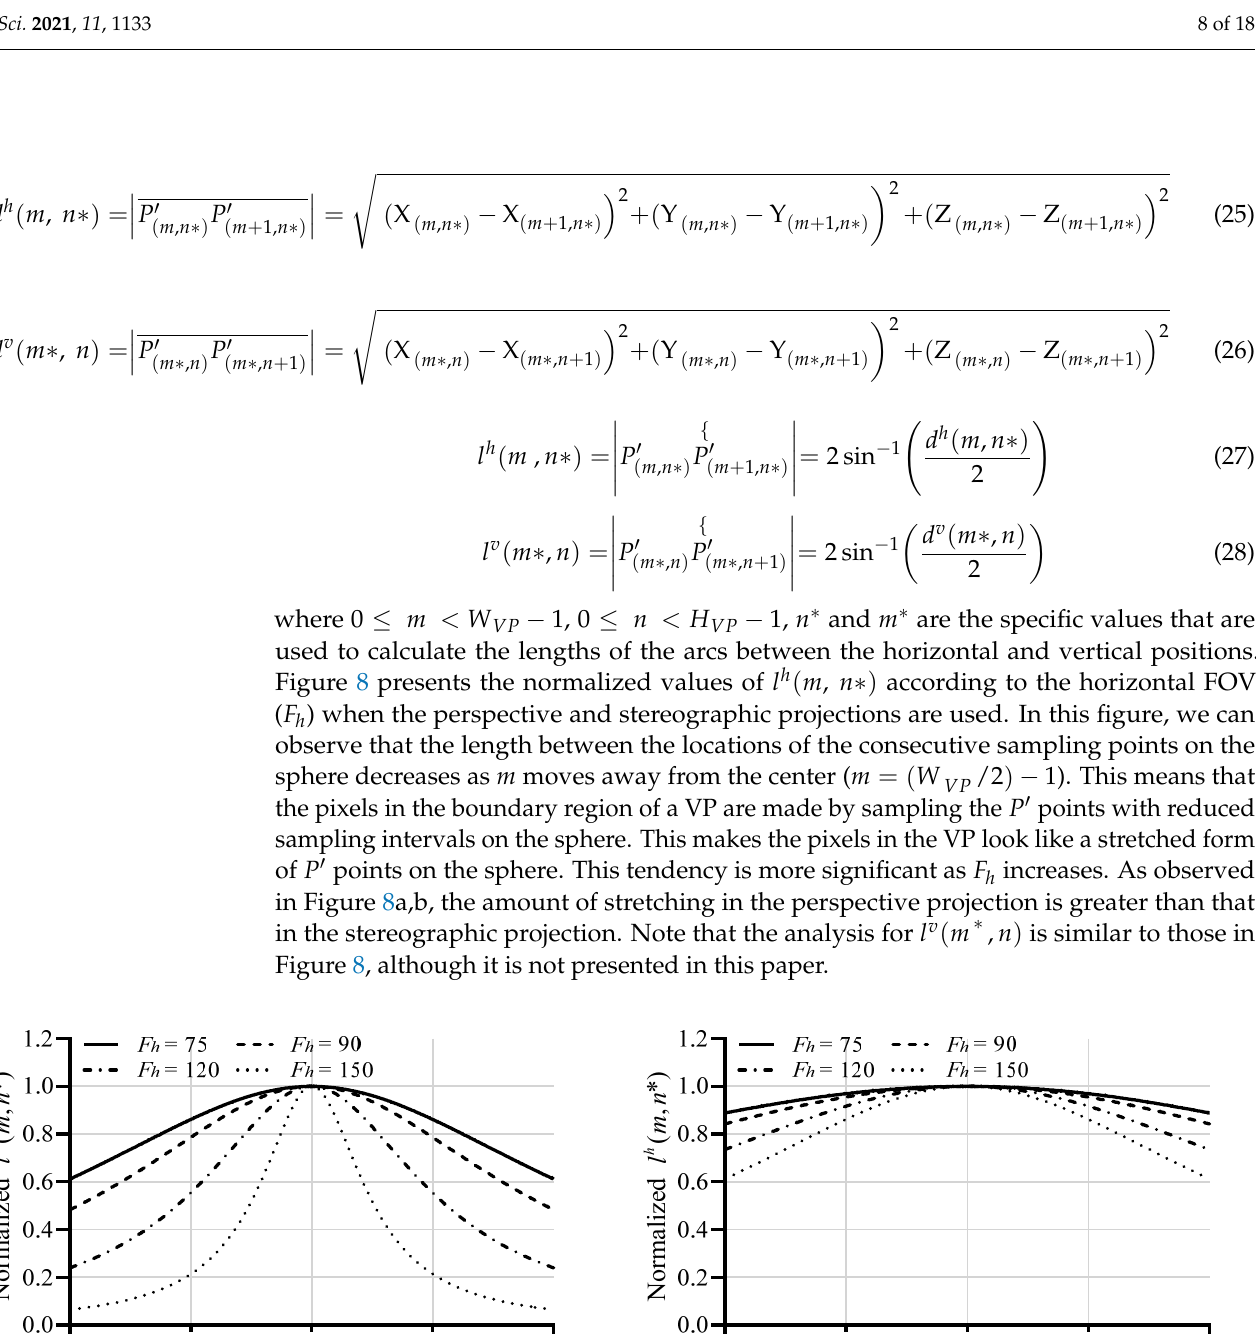
Figure 8. Normalized l h ( m , n ∗ ) when n ∗ = H VP